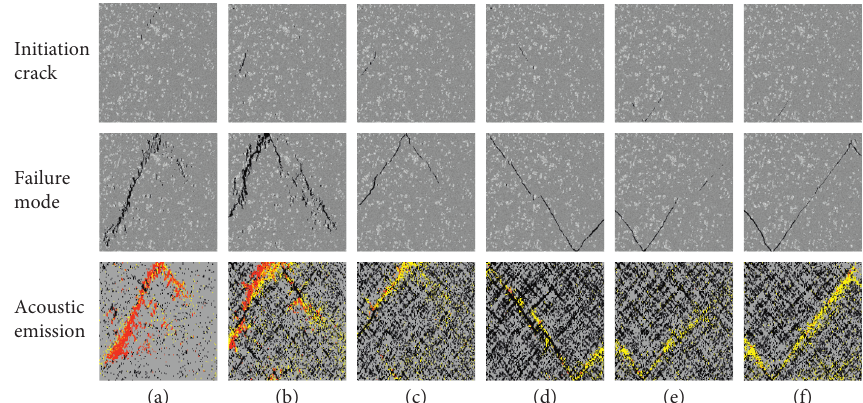
Figure 14: Fracture modes diagram of shale under different confining pressures and corresponding acoustic emission diagram. (a) 0MPa. (b) 2 MPa. (c) 4MPa. (d) 6MPa. (e) 8MPa. (f) 10